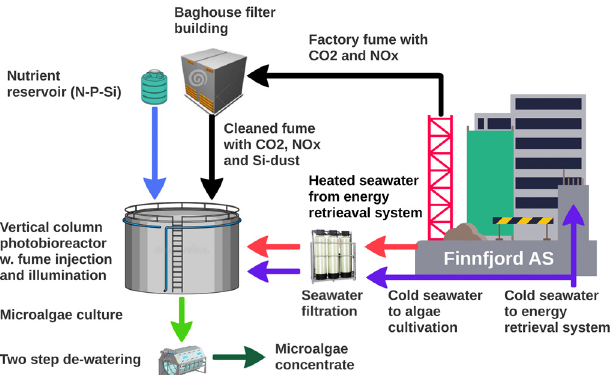
Figure 2. The main components of the microalgae cultivation system integrated in the production line at the ferrosilicon producer Finnfjord AS.